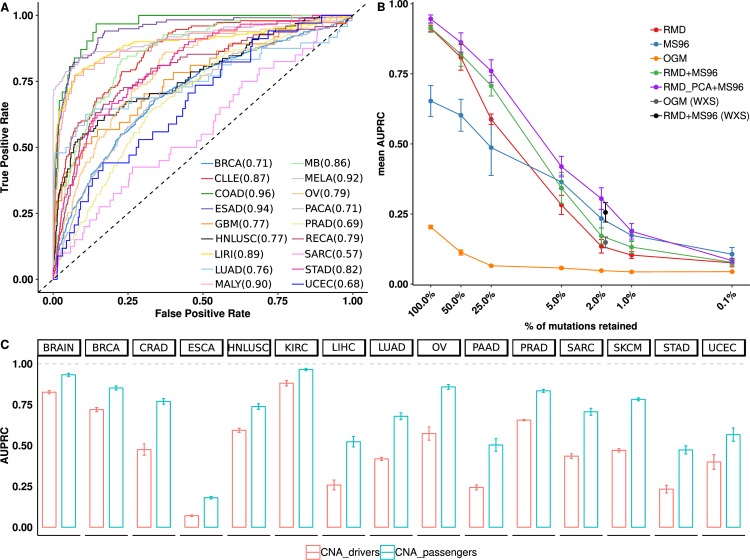
Predictive accuracy using data types other than whole-genome sequencing.(A) ROC curves for simulated whole-exome sequencing data, for one cancer type versus all others. Area under the ROC curve (mean across crossvalidation folds) for each cancer type is reported in the legend. (B) Crossvalidation AUPRC score for classifiers trained on various feature types under conditions of false negative mutation calls. (C) Crossvalidation AUPRC score for copy number states in 1Mb segments, estimated from SNP array data and tentatively divided into driver and passenger events. In (B) and (C), mean ± standard deviations are shown over multiple crossvalidation runs; (B) depicts the median score across all cancer types, and mean and s.d. thereof across crossvalidation runs are shown.